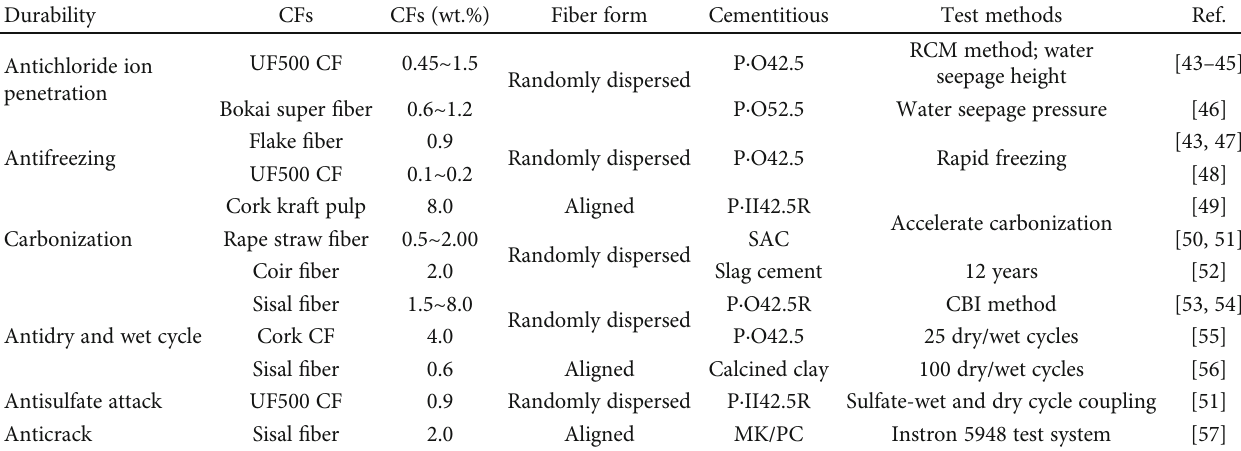
Table 3: Summary of studies on durability of